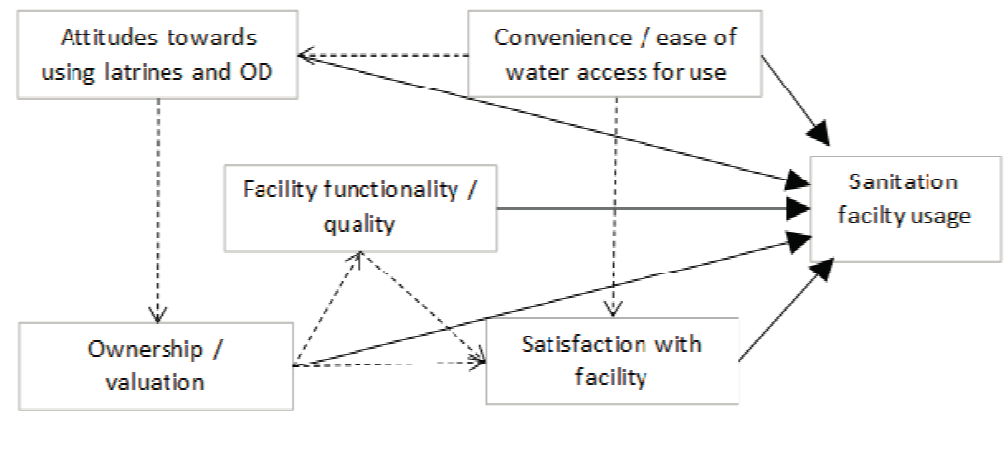
Figure 1. Factors that influence latrine use rates and open defecation behavior identified from India and global literature on latrine adoption and